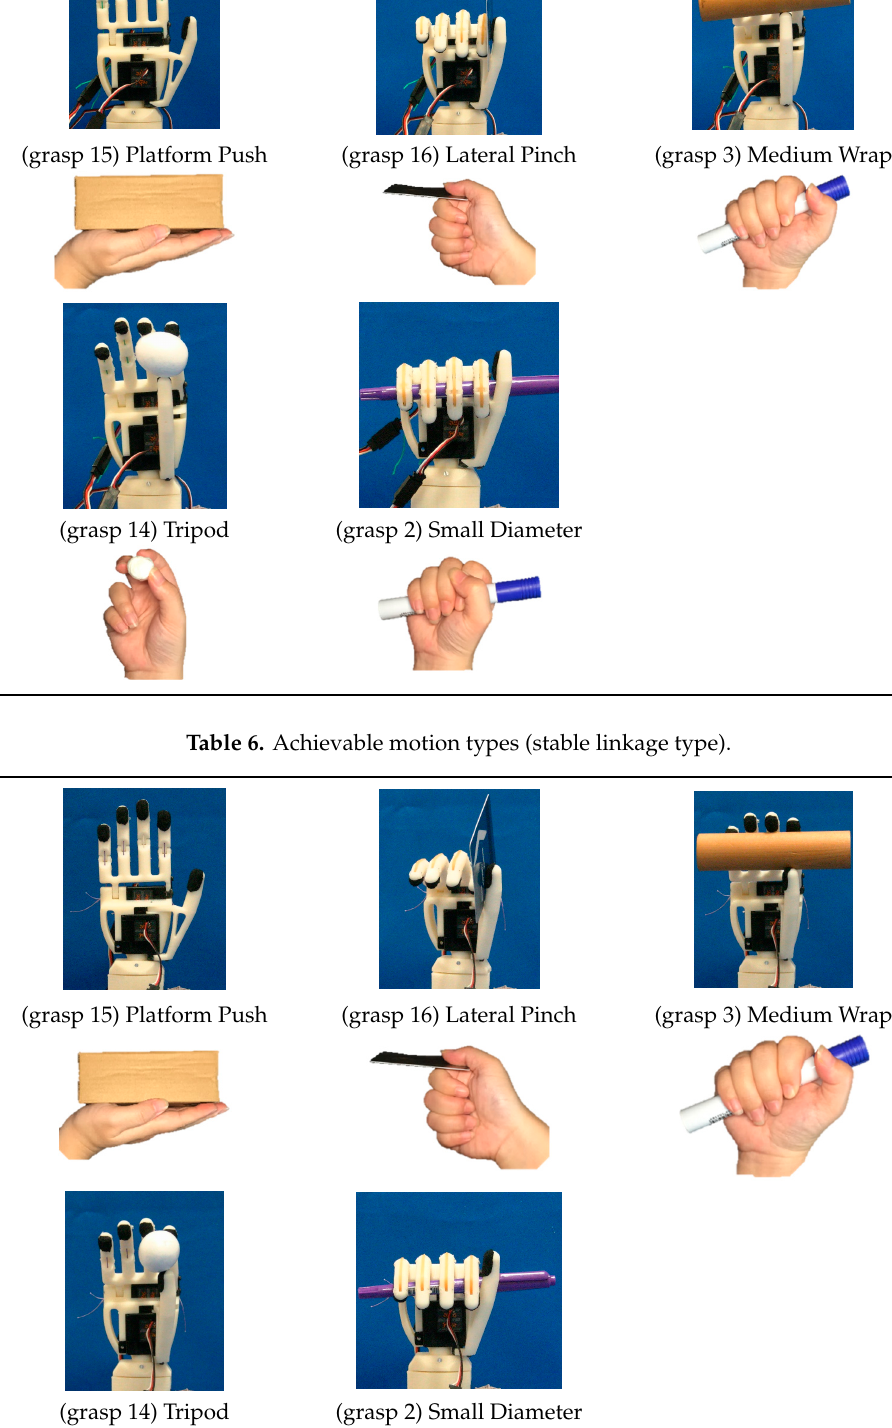
Table 5. Achievable motion types (adaptive linkage type). Appl. Sci. 2019 , 9 , x FOR PEER REVIEW